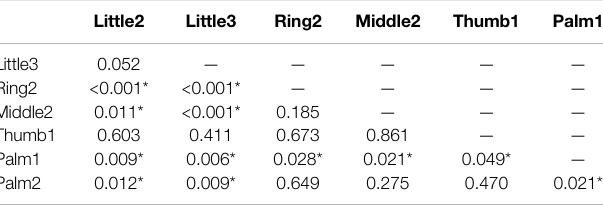
TABLE 2 | Statistical differences between the normal contact force sensors in various locations of the hand ( p -values). Little2